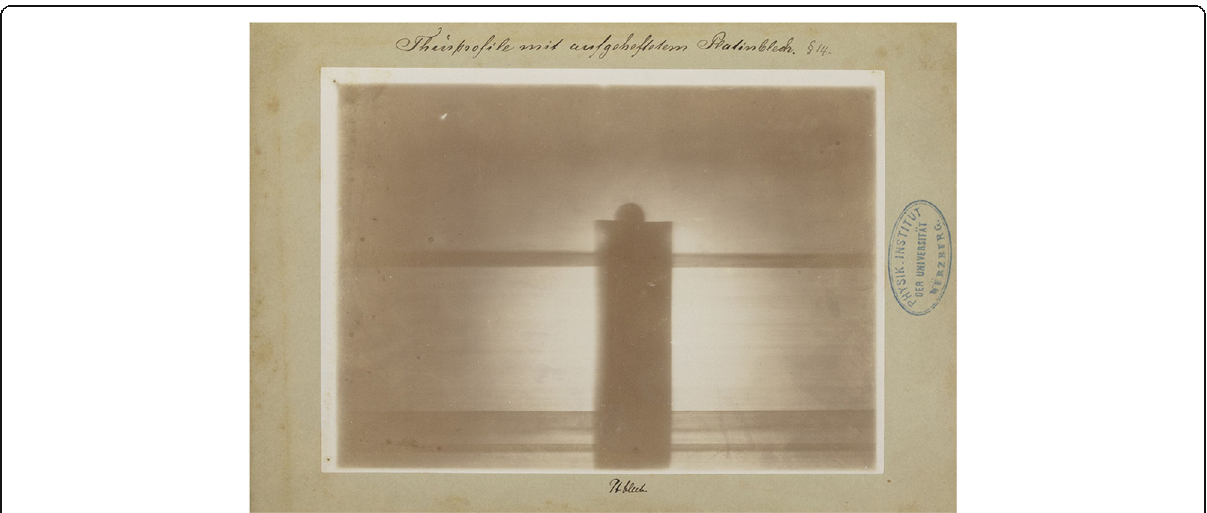
Fig. 4 The doorpost of Roentgen ’ s lab upon which he attached a thin sheet of Platinum. It shows that the X-ray attenuation of the thin plate of platinum is much larger than that of the thick wooden doorpost. Manually written legend: ‘ Thürprofile mit aufgeheftetem Platinblech ’ (Doorpost with attached thin plate of Platinum). Paragraph referral: § 14